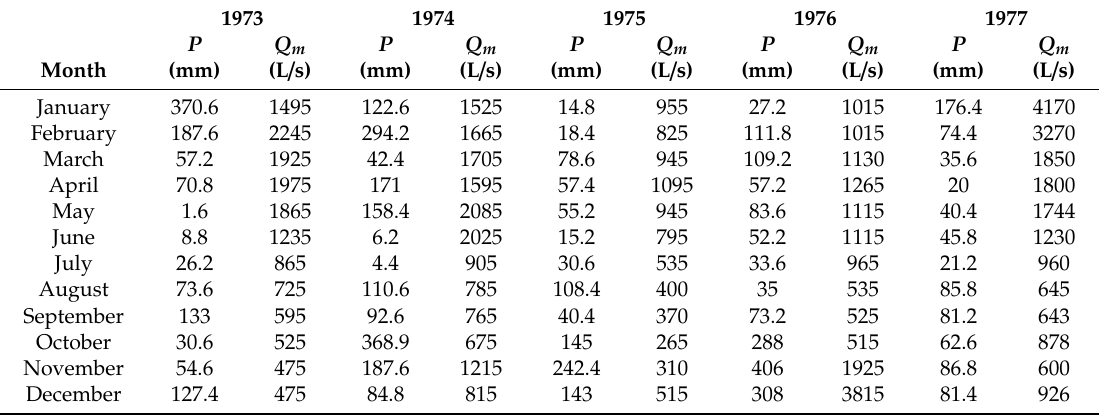
Table 1. Rainfall and Capodacqua di Spigno Spring discharges data for the model training period.